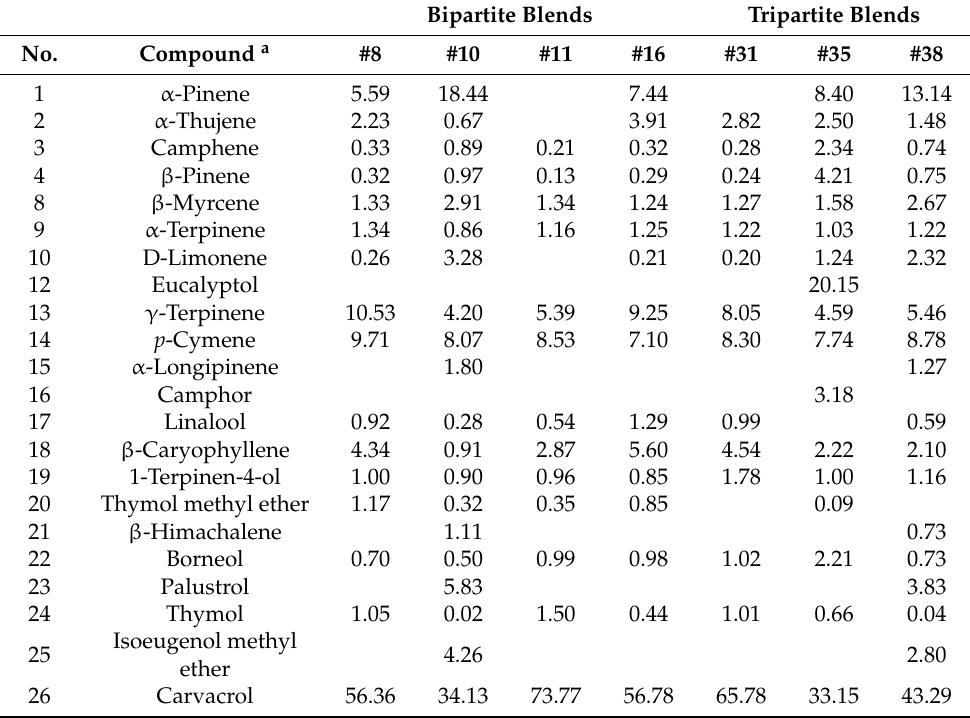
Table 1. Chemical composition (relative percentage % of the main compounds) of the most effective bi- and tripartite blends of essential oils (EOs) against Aeromonas veronii bv. sobria after evaluation of 127 preparations using all combinations of EOs of seven Greek native medicinal-aromatic